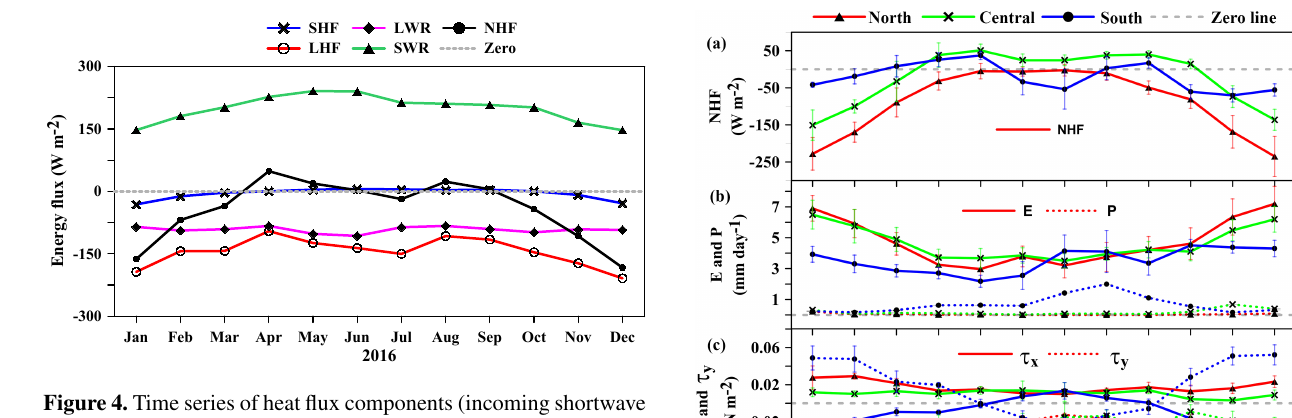
Figure 4. Time series of heat flux components (incoming shortwave radiation, SWR; longwave radiation, LWR; latent heat flux, LHF; sensible heat flux, SHF; and net heat flux, NHF) for the year 2016 in the central Red Sea.